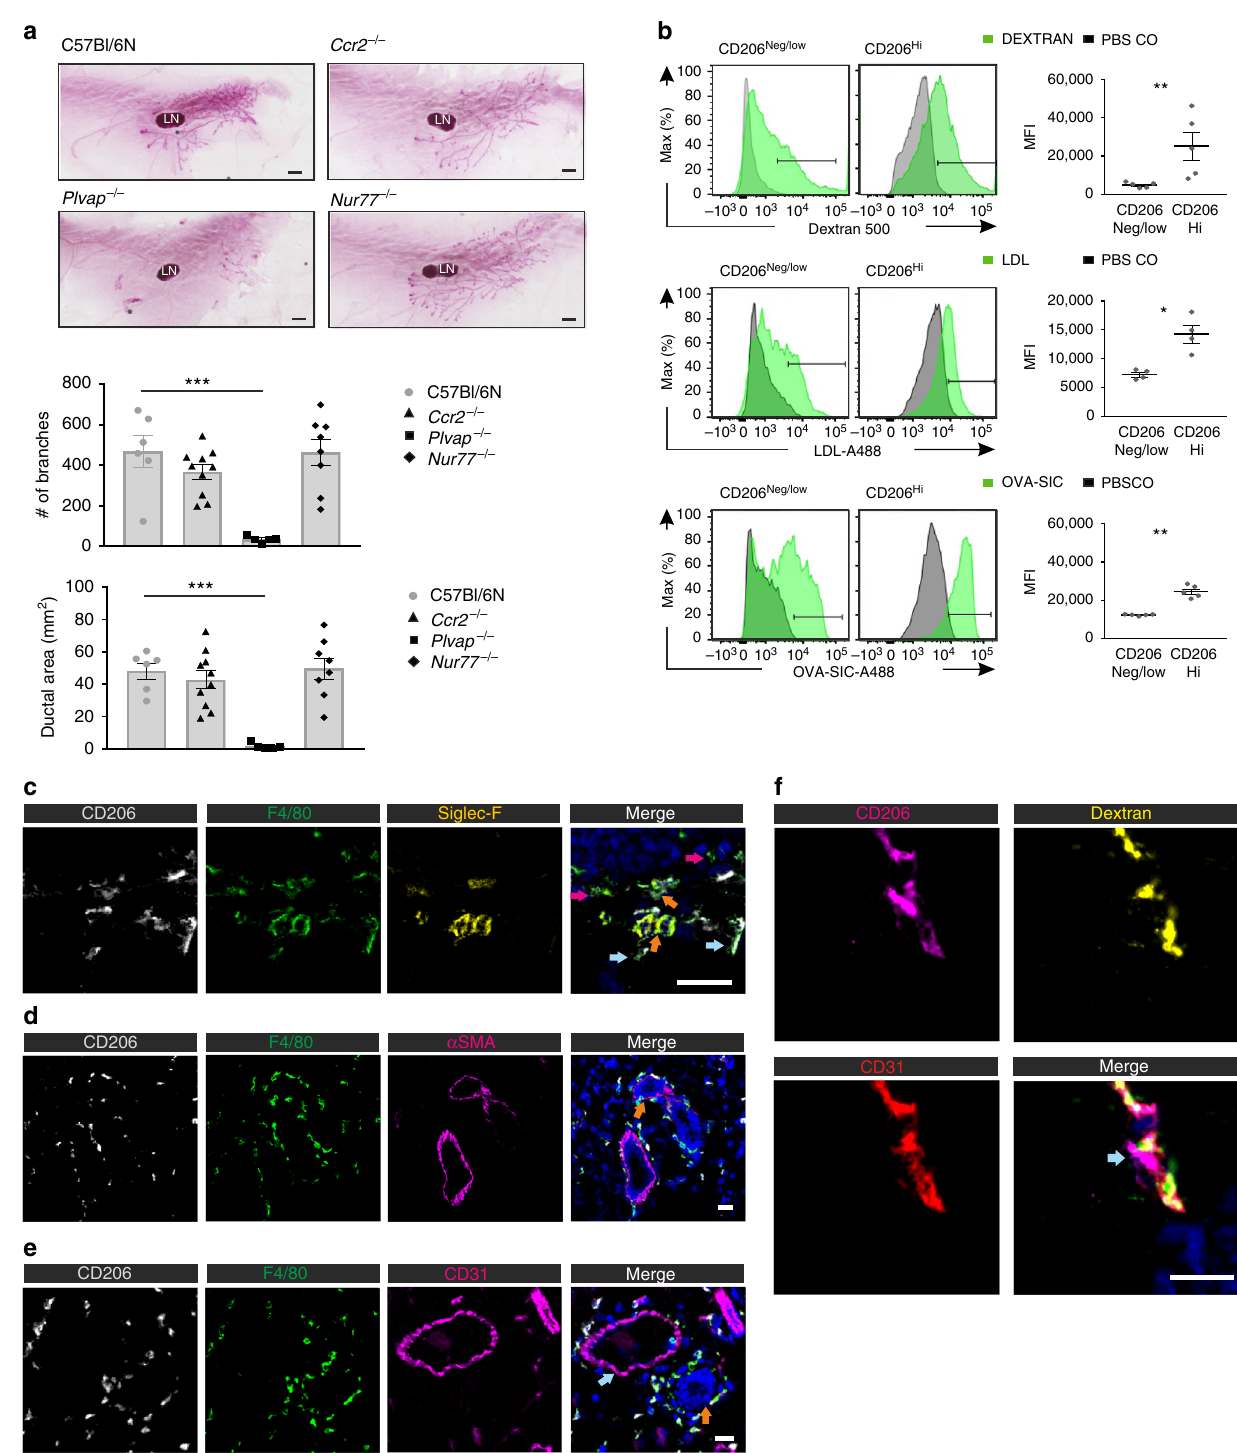
The distinct CD45 + cell populations were then manually assigned to different leukocyte subpopulations based on the expression of the cell-type selective leukocyte differentiation markers. In certain experiments (Supplementary Fig. 5a) the mass cytometry data was manually analyzed using bi-axial blottings to allow direct comparison with the fl uorimetric data. Alternatively, the data were uploaded to the VorteX clustering environment (https://github.com/nolanlab/vortex/releases/tag/29-Jun-2017). 10000 events were imported and all fi les were merged into one dataset (different datasets by the age). Fifteen parameters were selected for unsupervised hierarchial clustering with X-shift algorithm. For the clustering the default settings were used with